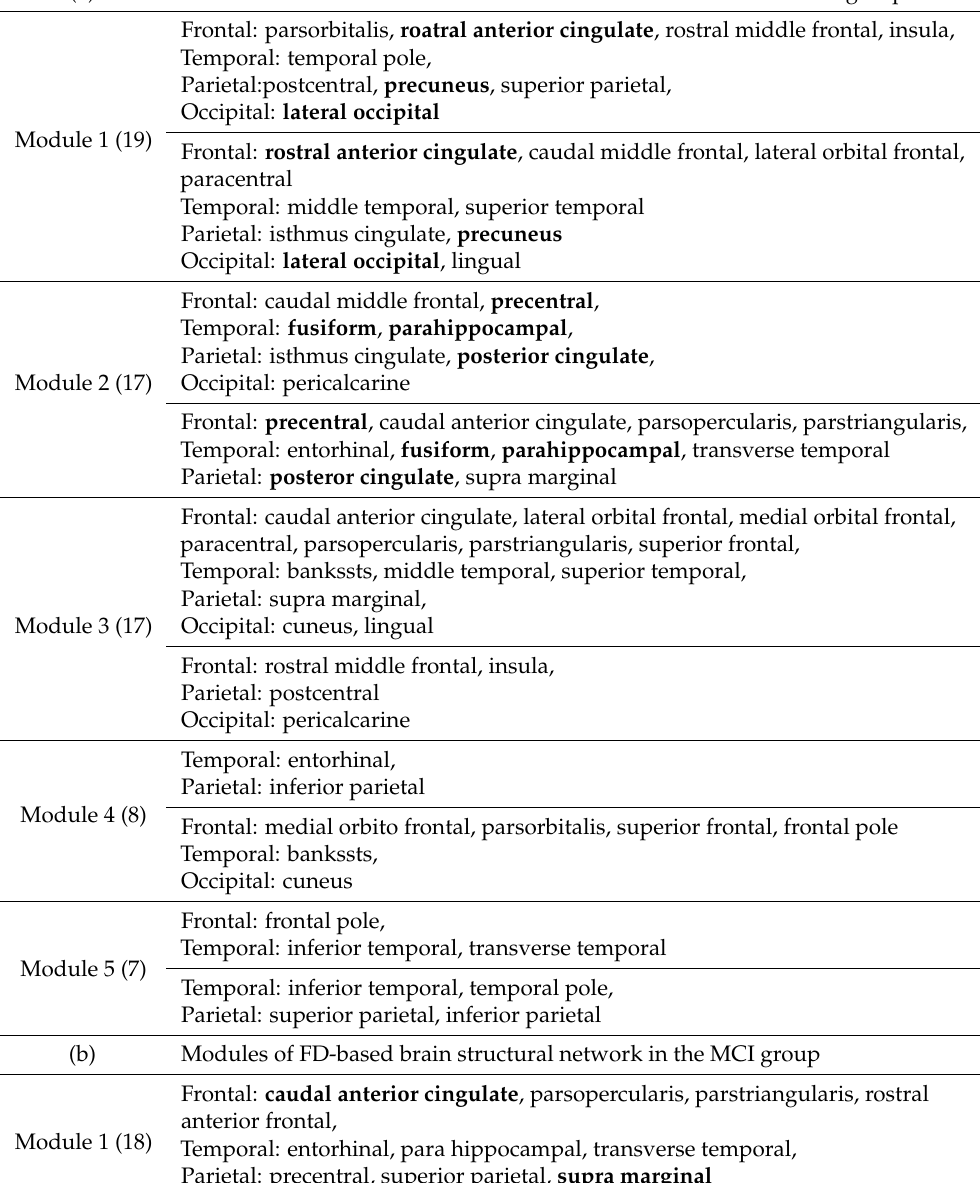
Table 5. The detailed subregions within each module of the modular brain network for the normal control and MCI groups. (a) Modules of FD-based brain structural network in the control group (b) Modules of FD-based brain structural network in the MCI group. Bold in the table indicates the pair of bilateral node links in the same